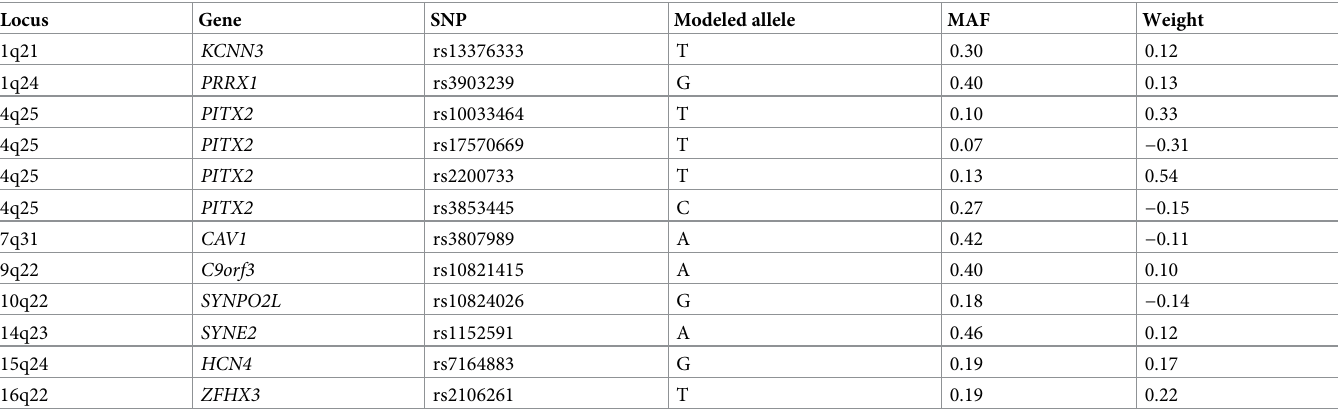
Table 1. Single nucleotide polymorphisms associated with AF used for the determination of the AF GRS.